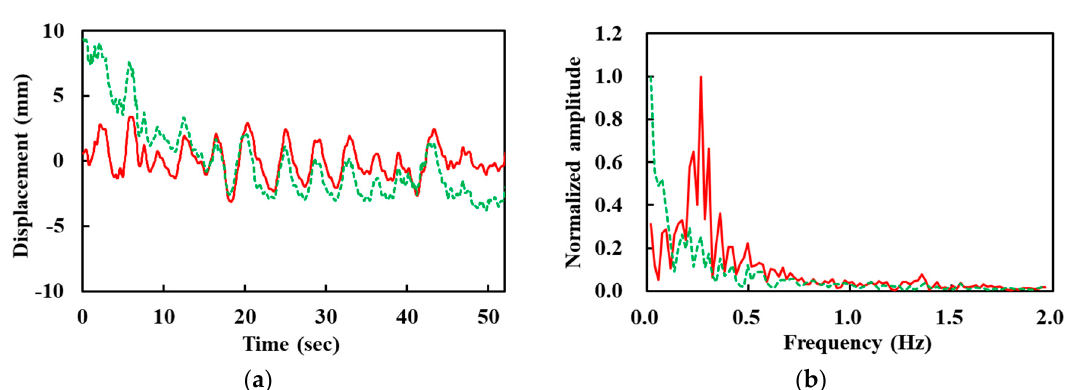
Figure 5. Demodulated ( x d [ n ] , dashed) and trend-removed signals ( x d , t [ n ] , solid). ( a ) Time-domain